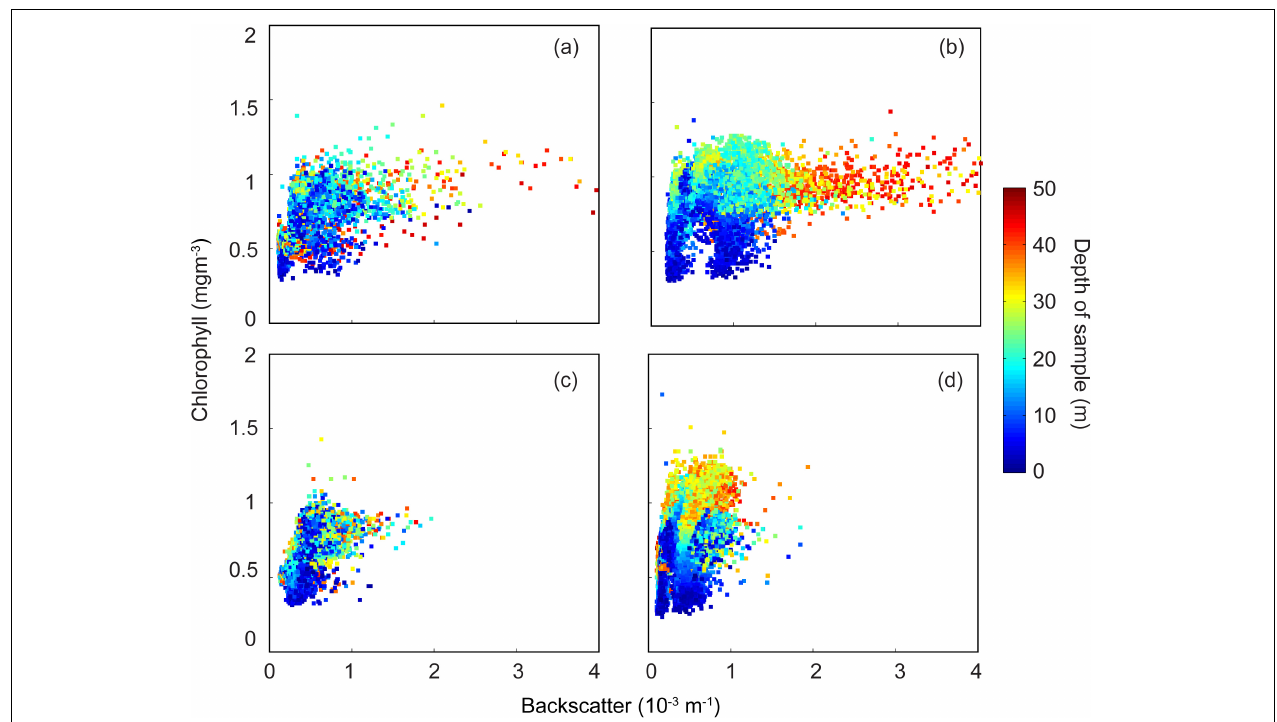
FIGURE 6 | Backscatter (m − 1 ) and chlorophyll (mg m − 3 ) scatter plot. (a) 17–19 September 2011; (b) 23–25 September 2011; (c) 27–28 September 2011; and, (d) 28–30 September